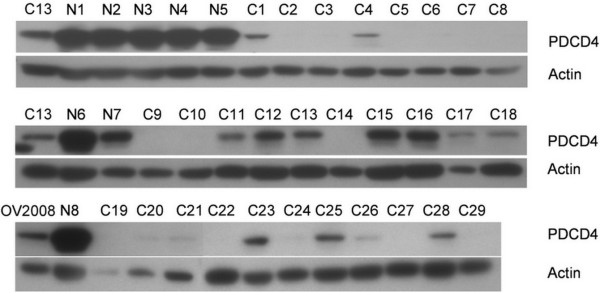
Western blot analysis of Pdcd4 expression in normal ovarian and malignant ovarian tissue samples. A representative of 8 normal samples (N1-8) and 29 malignant samples (C1-29) indicated significant higher Pdcd4 protein expression in normal compared with malignant ovarian tissue samples. Ovarian cancer cell line C13 or OV2008 were included as positive control and β-actin as loading control.